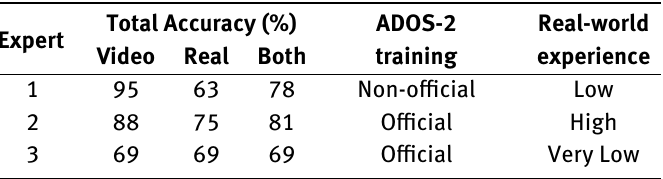
Table 3: Accuracy and agreement results per feature, including comparison with percent agreement values from the ADOS-2 literature with